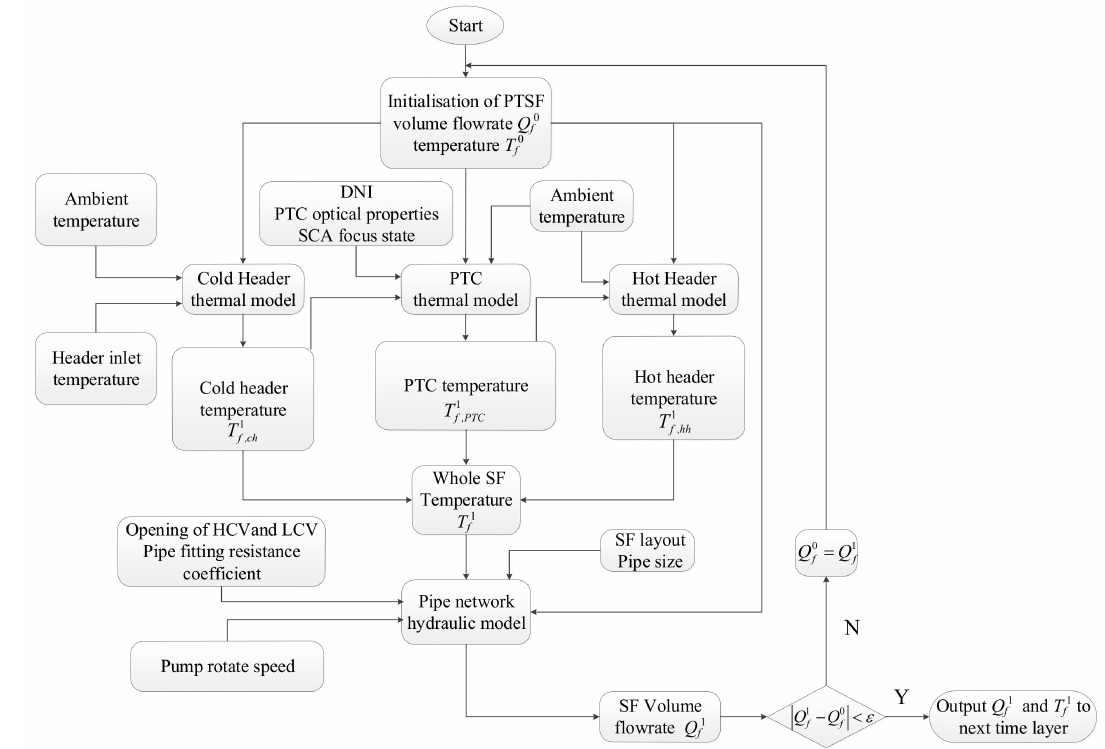
Figure 7. Flow chart of the comprehensive thermal hydraulic model